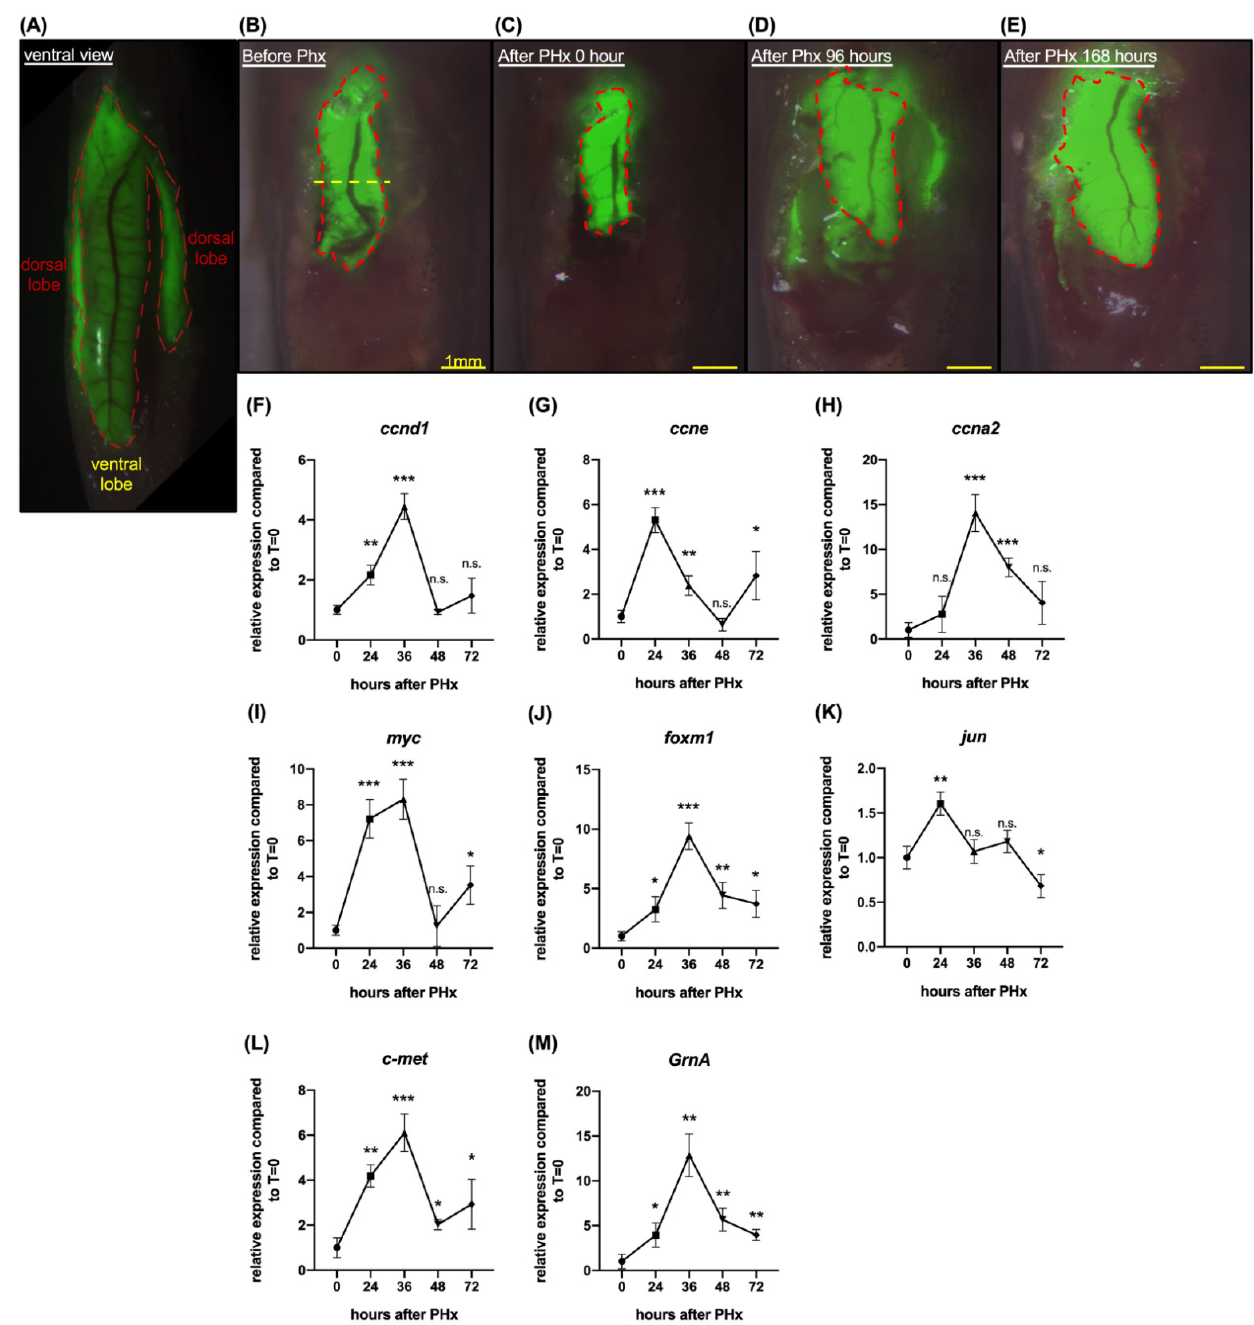
Figure 1. Liver regeneration was induced by one-half ventral lobe partial hepatectomy in 7 days. ( A ) Ventral view of Tg(fabp10:EGFP) . The green fluorescent area marked by the red dotted line is the liver of Tg(fabp10:EGFP) . ( B ) Schematic diagram of one-half ventral lobe partial hepatectomy (PHx). The regenerating ventral lobe is shown at 0 h ( C ), 96 h ( D ), and 168 h ( E ) after PHx. Area marked by the red dotted line is the liver ventral lobe. Yellow dotted line, the site of PHx. Scale bar: 1 mm. Gene expression was examined by quantitative PCR. Cell cycle regulatory genes included ( F ) ccnd1 , ( G ) ccne , and ( H ) ccna2 . Cell proliferation-associated genes included ( I ) myc , ( J ) foxm1 , and ( K ) jun . ( L ) Gene expression of c-met . ( M ) Gene expression of GrnA . The relative expression levels compared to control at 0 h PHx are presented as mean ± SD. Significance was set at * p < 0.05, ** p < 0.01, *** p < 0.001, as determined by t -test; PHx, partial